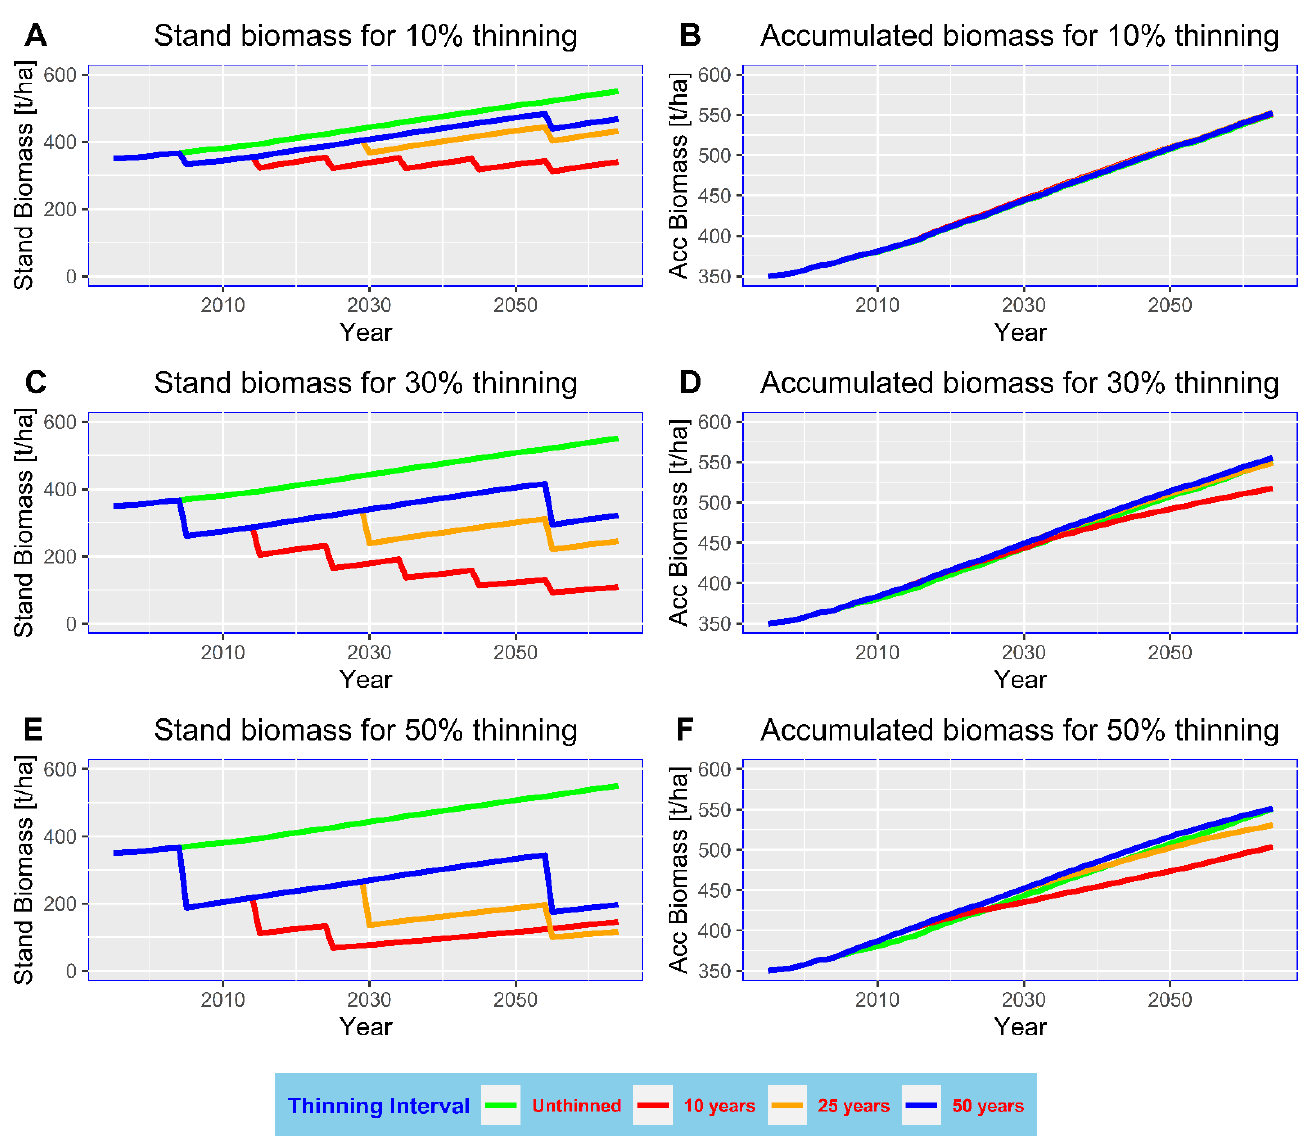
Figure 1. Stand biomass ( A , C , E ) and accumulated biomass ( B , D , F ) at 10%, 30% and 50% thinning respectively in different thinning intervals. respectively in different thinning